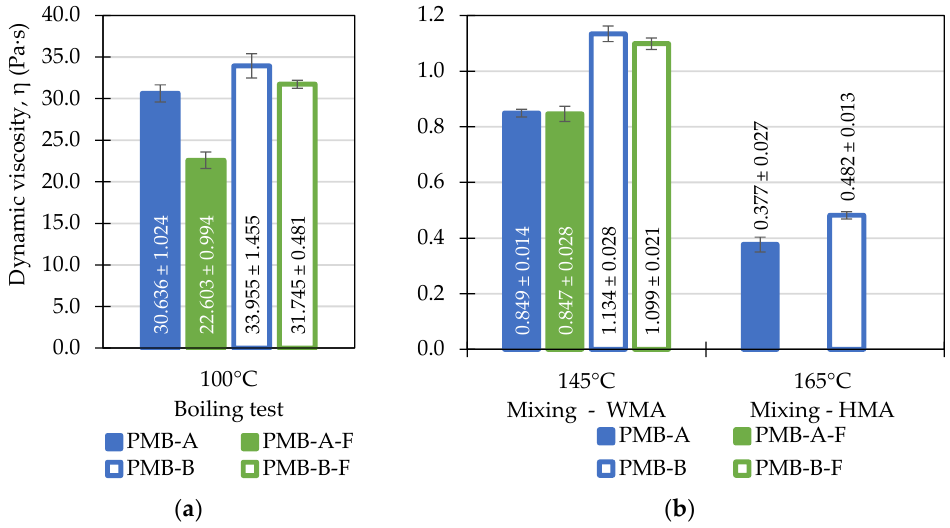
Figure 6. Results of the dynamic viscosity testing of the investigated polymer-modified bitumen (PMB) before and after foaming (F) evaluated at: ( a ) 100 °C — the temperature of the boiling water stripping tests; ( b ) 145 °C and 165 °C — the aggregate-binder mixing temperatures.